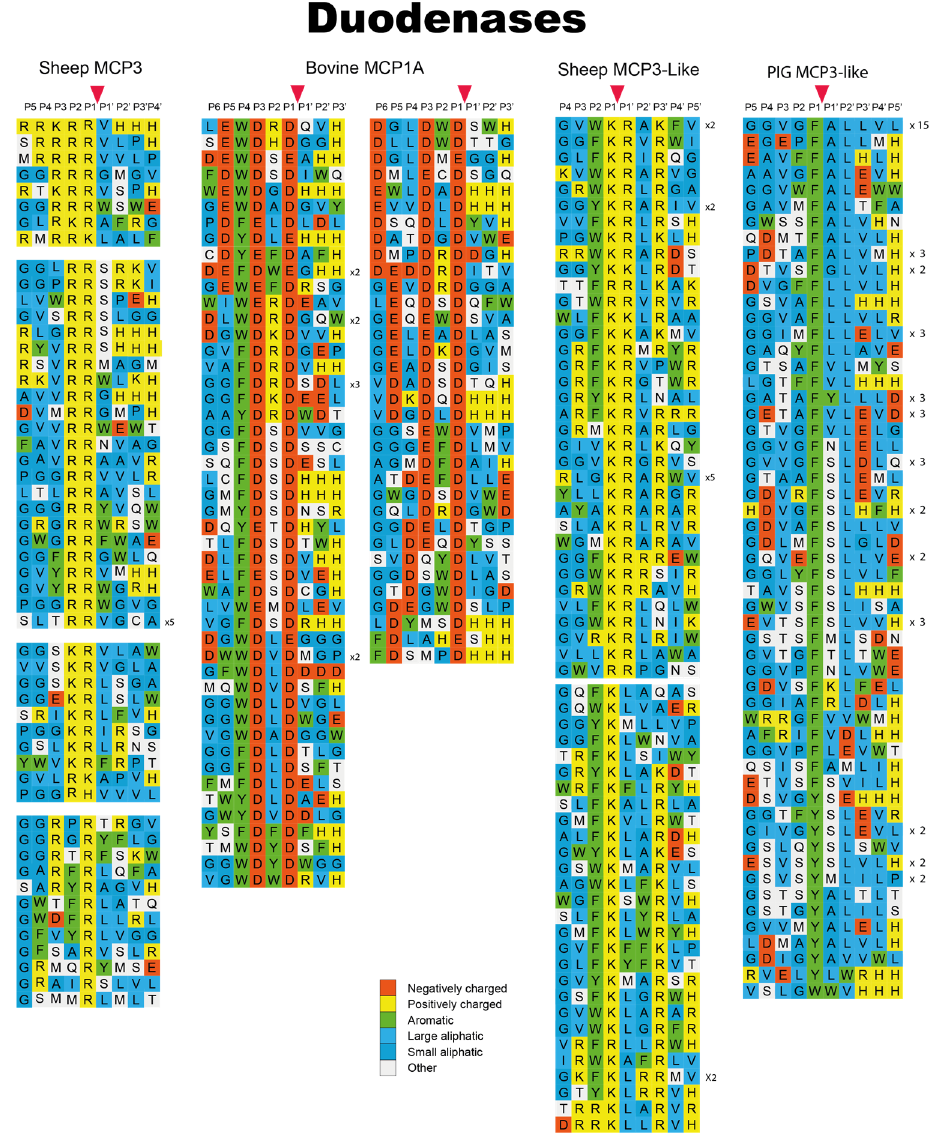
Figure 8. Phage display results for a panel of duodenases from cattle, sheep and pig. The amino acids in the phage display results are color coded as shown in the bottom of the figure. The cleavage by the enzyme occur after the P1 residue. The figure contains data from one earlier publication